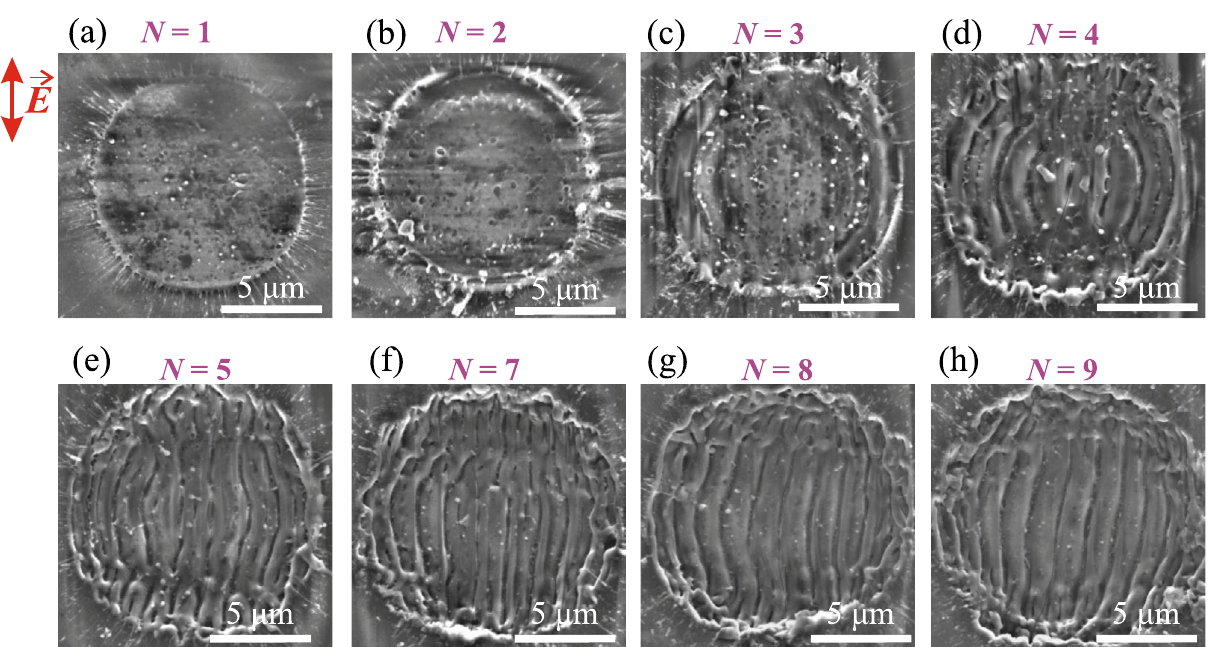
Figure 2. SEM images of fused silica surface after irradiation with different number of linearly polarized 200 fs, 1.7 µ m pulses with a fixed fluence of 4.6 J/cm laser